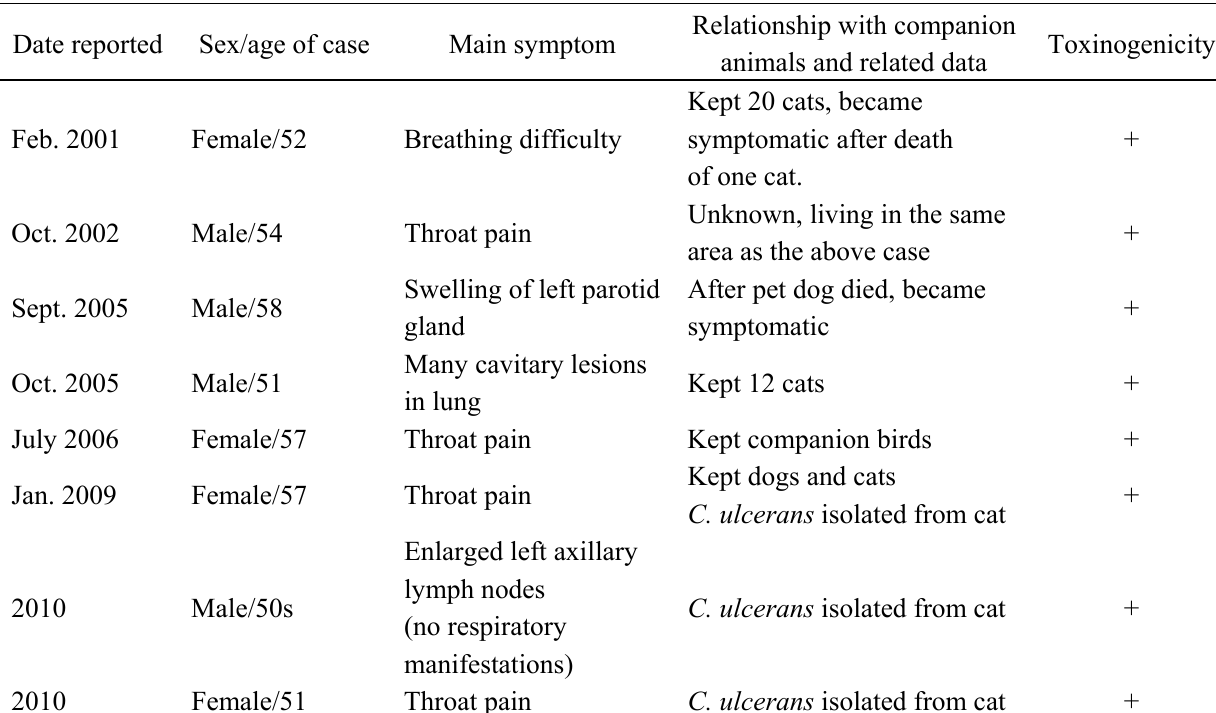
Table 6. Cases of human C. ulcerans infection in